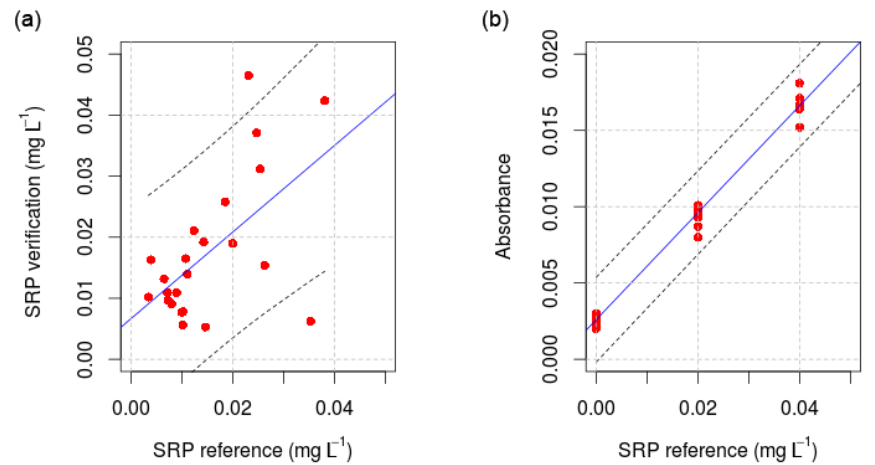
Figure 4. (a) Linear regression model linking the reference data and a verification data set; (b) measurement error as estimated from a repeatability test performed by the laboratory in charge of producing reference data (blue line: fitting regression; black dashes: 90% prediction interval).